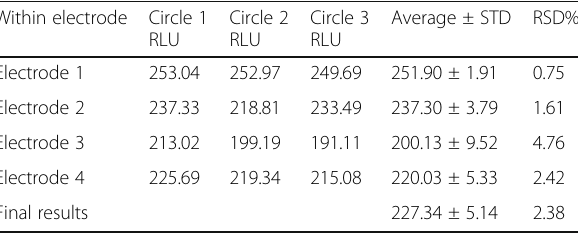
Table 1 The precision of immobilisation ferrocene tagged antibody on the ITO electrode surface Within electrode Circle 1 Circle 2 Circle 3 RLU RLU RLU